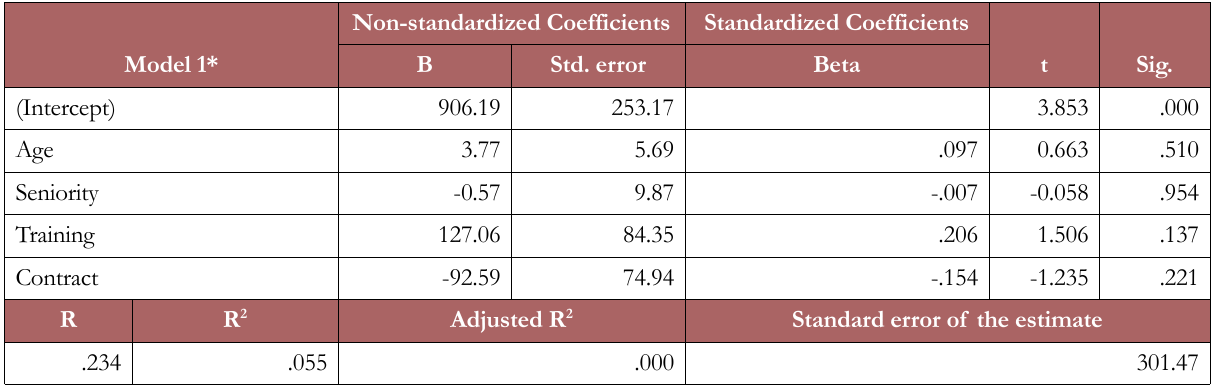
Table 6. Model 1. Linear regression analysis with worker-related